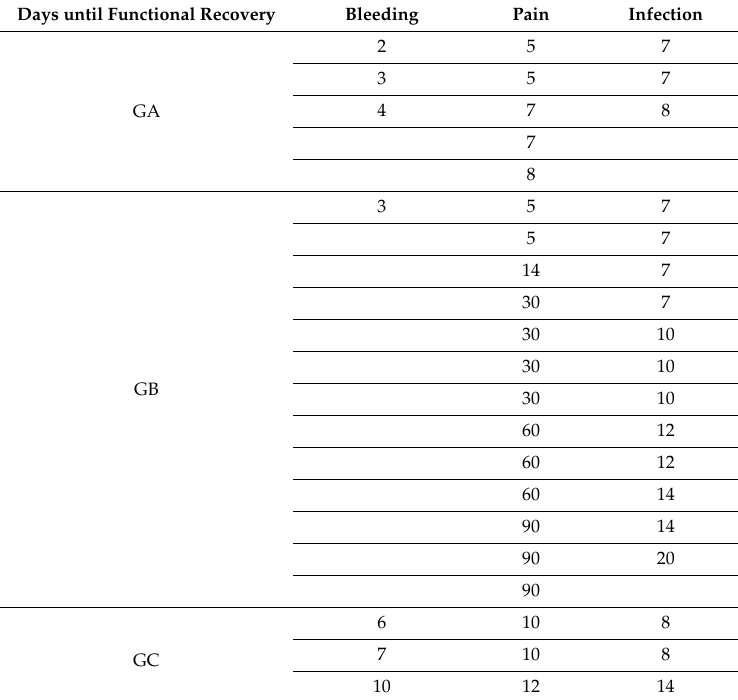
Table 1. Days until functional recovery by complication ( n ).